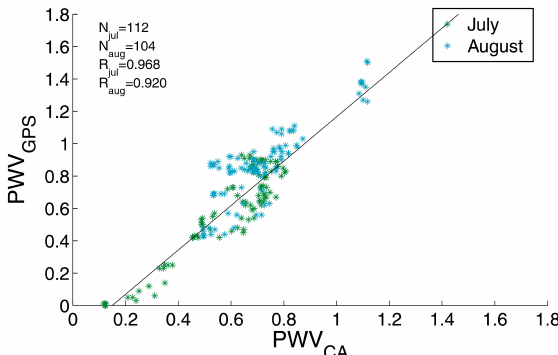
Fig. 2 : Correlation between PWV (cm) obtained by means of GPS-U and CA database. The Fig. 2. Correlation between PWV (cm) obtained by means of GPS- U and CA database. The number of pairs and the correlation coeffi- number of pairs as well as the correlation coefficient ( R ) for each month have been included. cient ( R ) for each month have been included. The solid line repre- Solid line represents the linear regression line. sents the linear regression